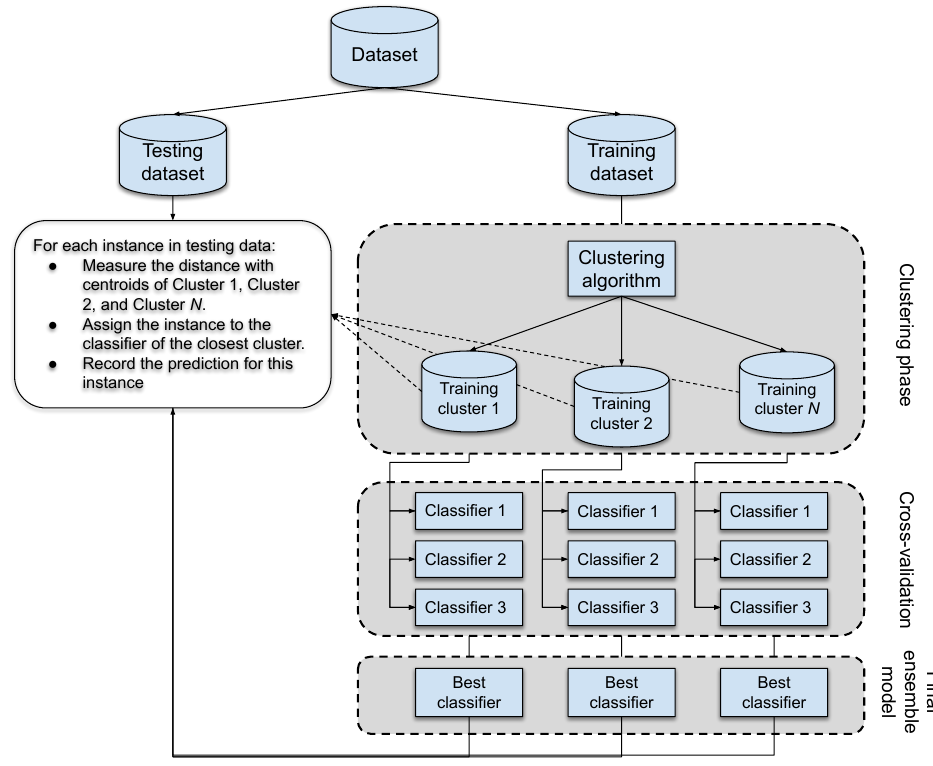
Figure 1. Proposed methodology for software defect